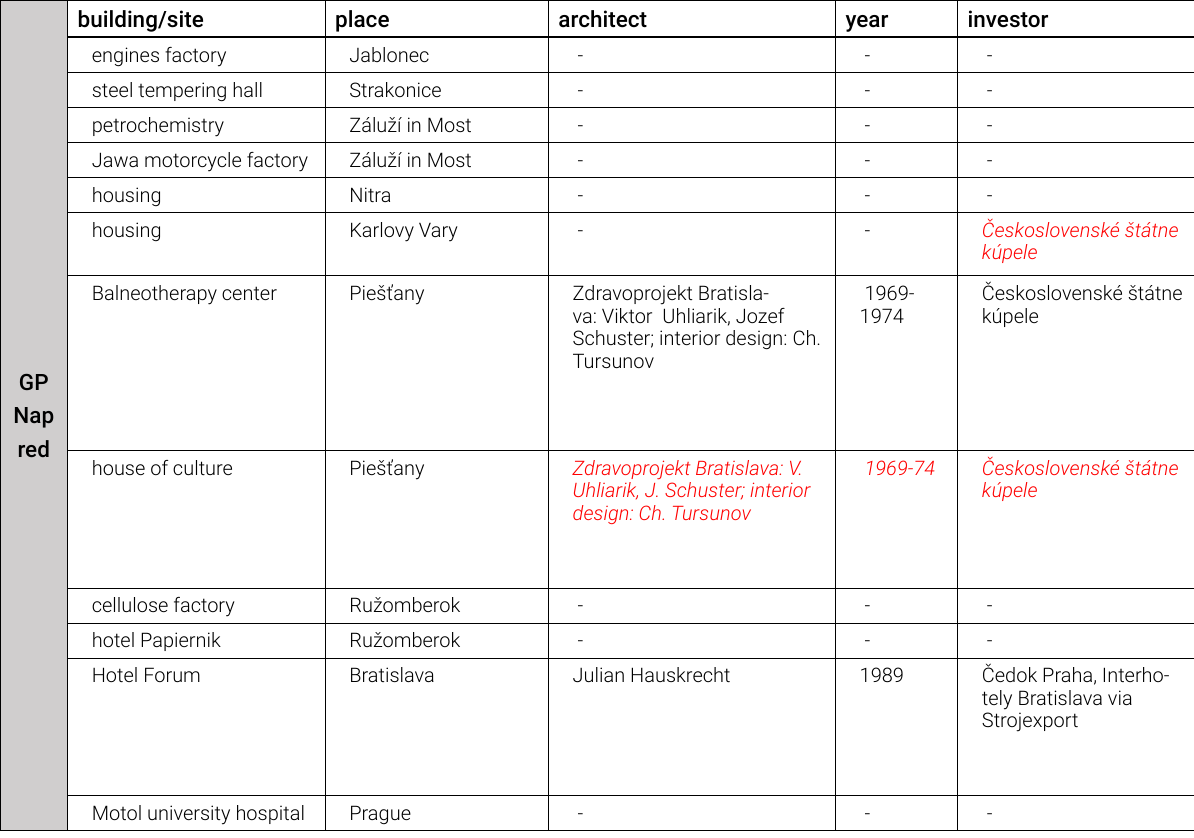
Table 1: Construction Sites of the GK Komgrap Construction